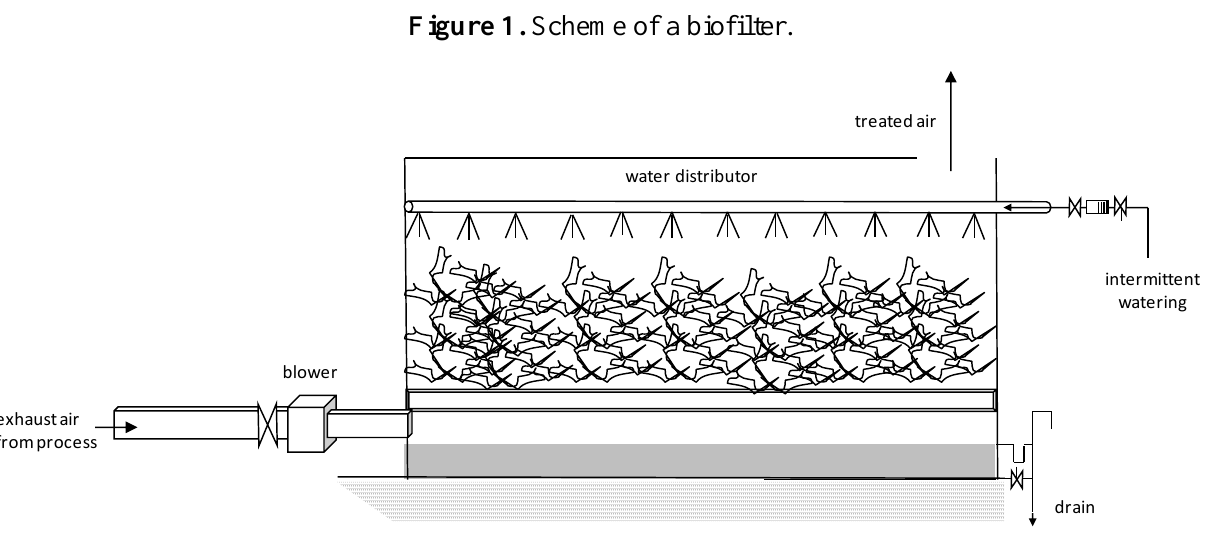
Figure 1. Scheme of a